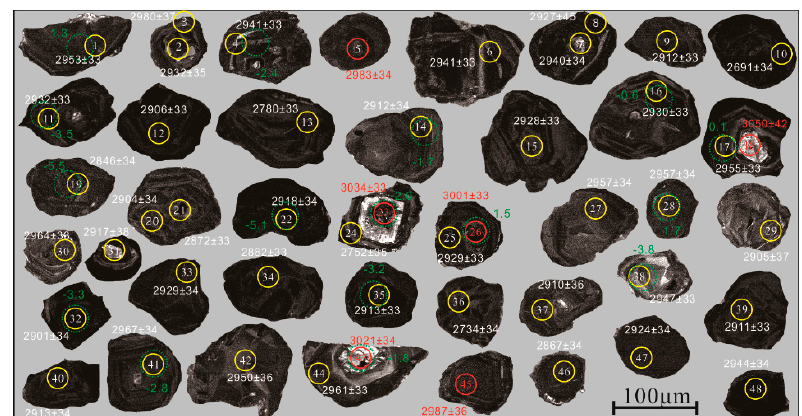
Figure 4. Representative cathodoluminescence images of zircons from the biotite–tremolite schist (D0002-1). The yellow circles show the locations of the LA–ICP–MS U–Pb analyses. The white number in each circle is the number of the analysis. The white number outside each circle is the age (Ma) for each site. The red circles and numbers give the analysis numbers and ages (Ma) for the smaller relict cores in those complex zircons.